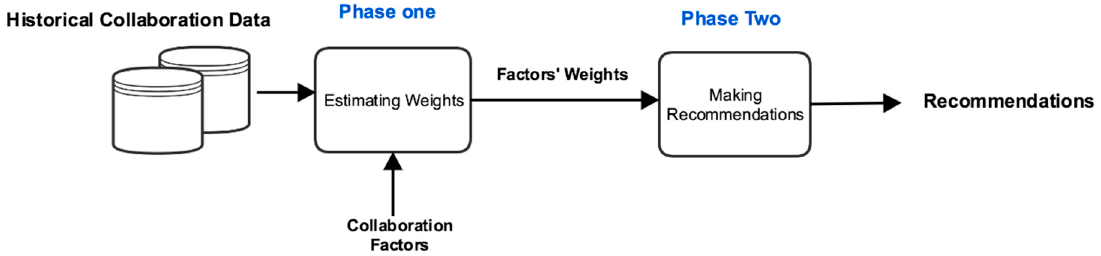
Figure 1. Method overview.